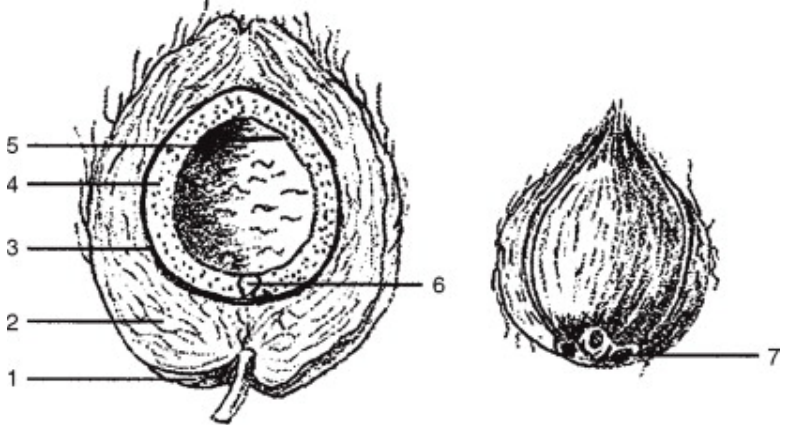
Figure 1. Longitudinal section of coconut and plan view of stone. Coconut fibers are mostly brown in color with varying lengths and diameters. More- over, other properties such as tensile strength and modulus of elasticity vary